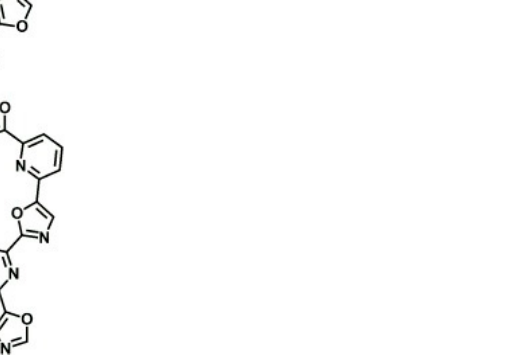
Figure 8. The unique geometrical features of TOxaPY enable the recognition of a peculiar antiparallel topology by groove-binding to it. Reprinted with permission from Wiley—Ref [56].